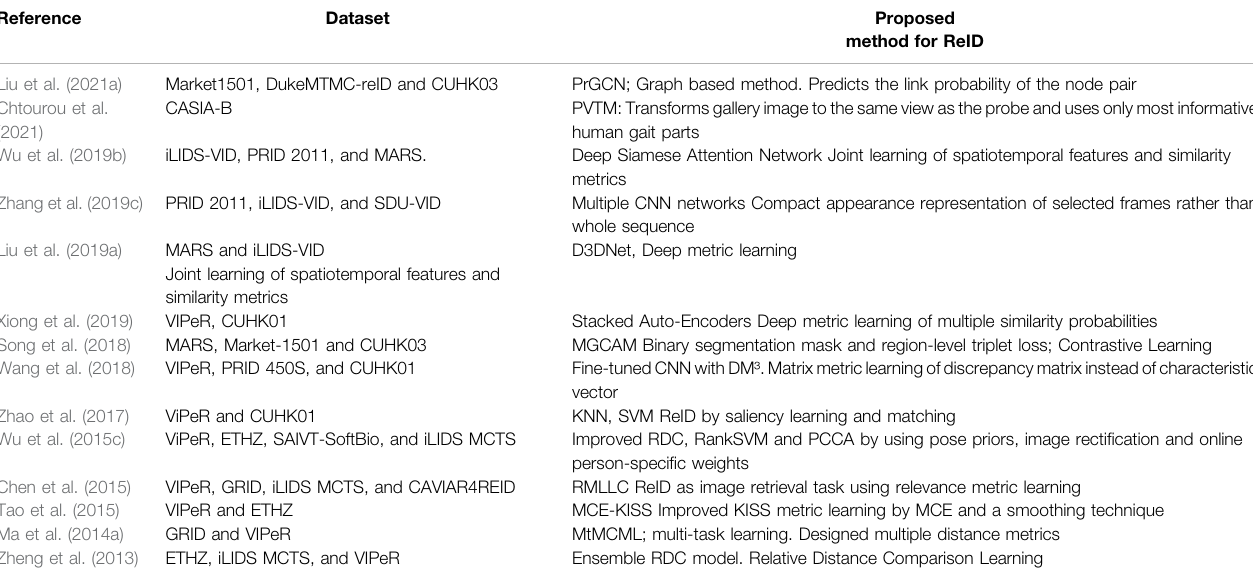
TABLE 9 | Human Re-Identi fi cation. Reference